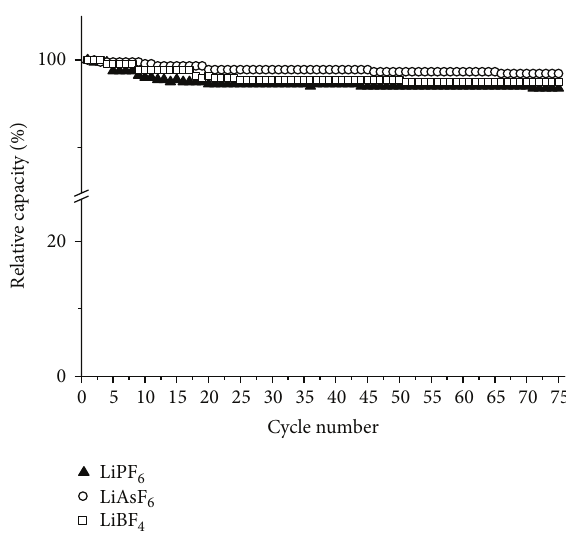
Figure 11: The cycle performance of the organic radical